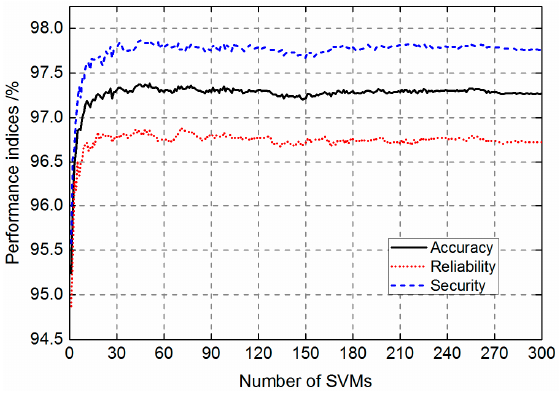
Figure 13. Prediction results of SVM ‐ based ensemble classifiers using different numbers of SVMs.